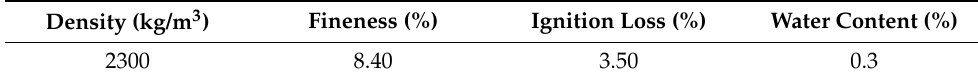
Table 2. Material properties of fly ash.